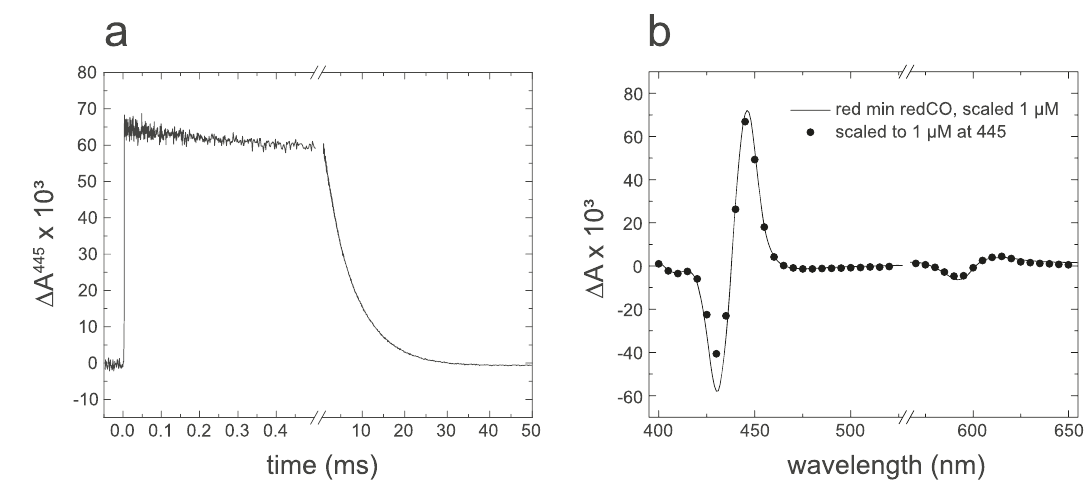
Fig. 4 Binding of the CO ligand to reduced CIV. a Absorbance changes monitored at 445 nm after fl ash-induced CO dissociation from the fully reduced enzyme. b Kinetic difference spectrum (closed circles) of the CO-recombination component in ( a ) and a difference spectrum of the reduced minus reduced-CO state, recorded using a spectrophotometer. Experimental conditions: 50 mM KH 2 PO 4 , pH 8, 150 mM KCl, 0.05 % DDM, 2 mM ascorbate and 1 µ M PMS (redox mediator), 1.2 mM CO. The CIV concentration was ~1 µ M and all traces are scaled to 1 µ M reacting enzyme. The kinetic trace in ( a ) is an average of 25